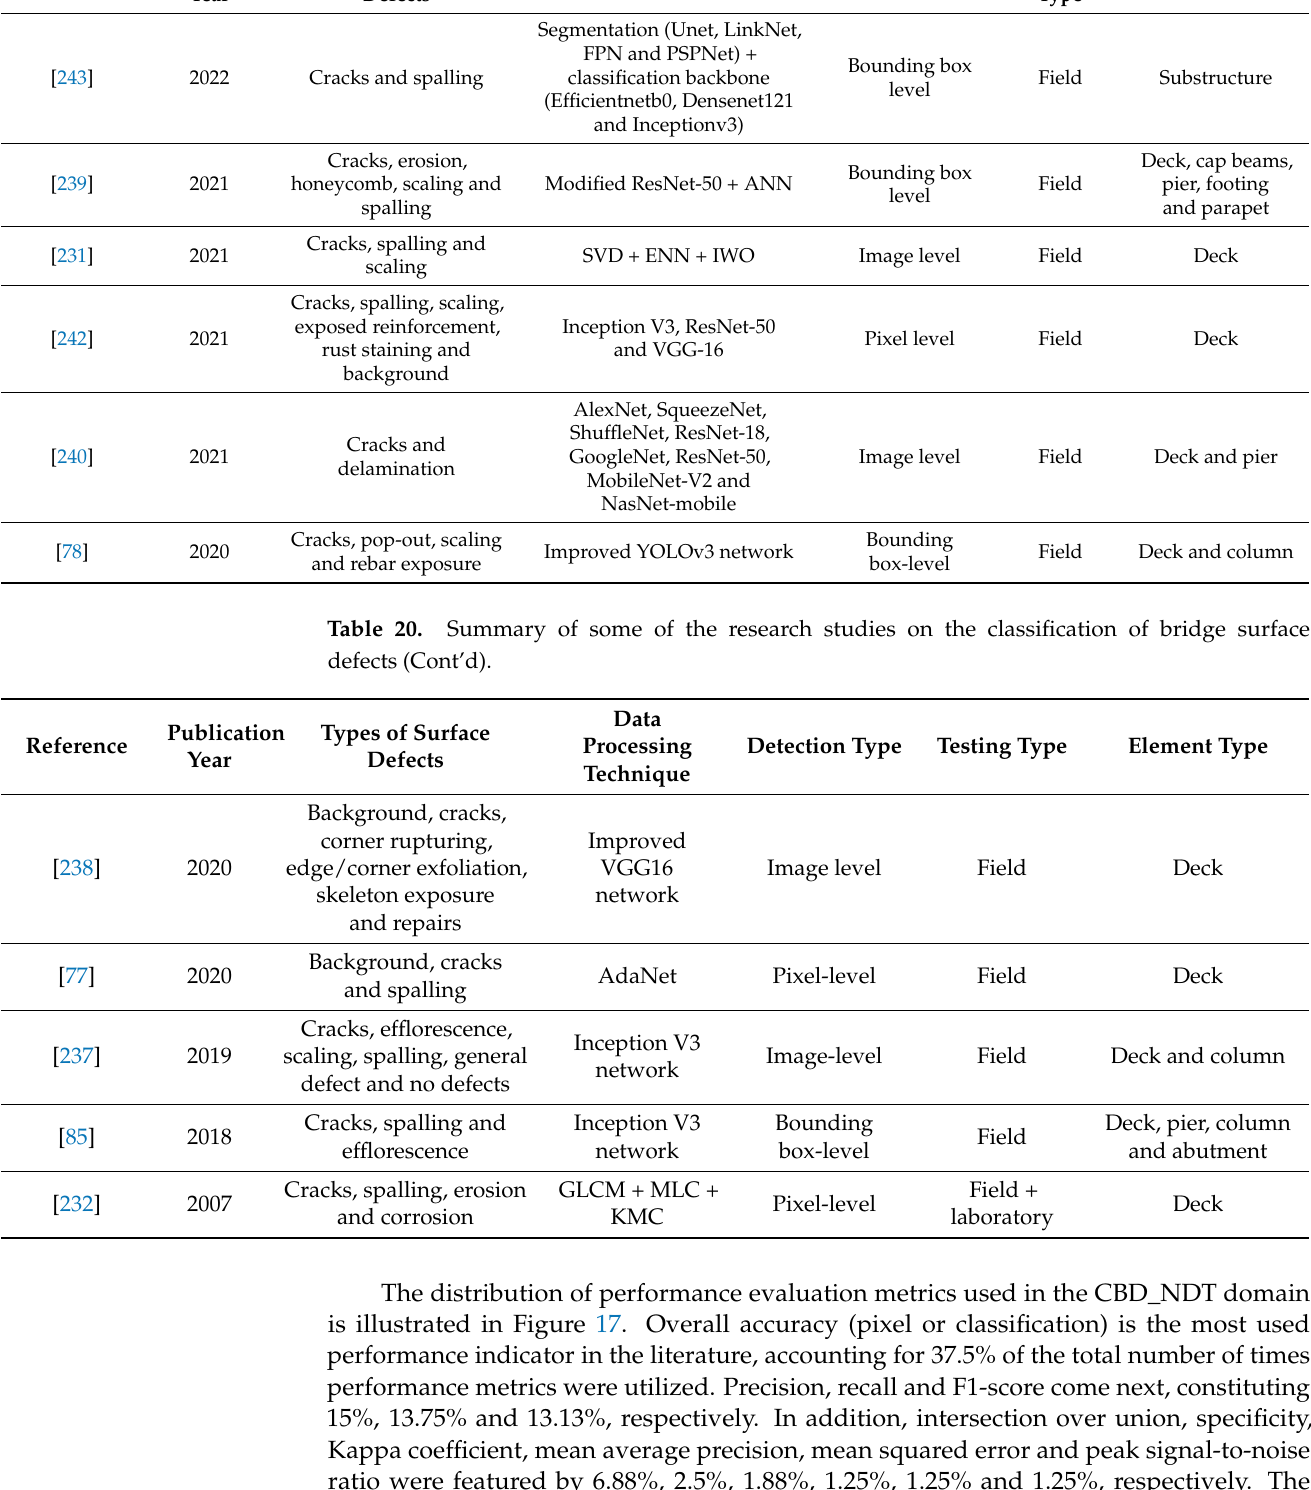
curve, balanced accuracy, error rate, mean absolute error, Matthew’s correlation coefficient, and frequency-weighted intersection over